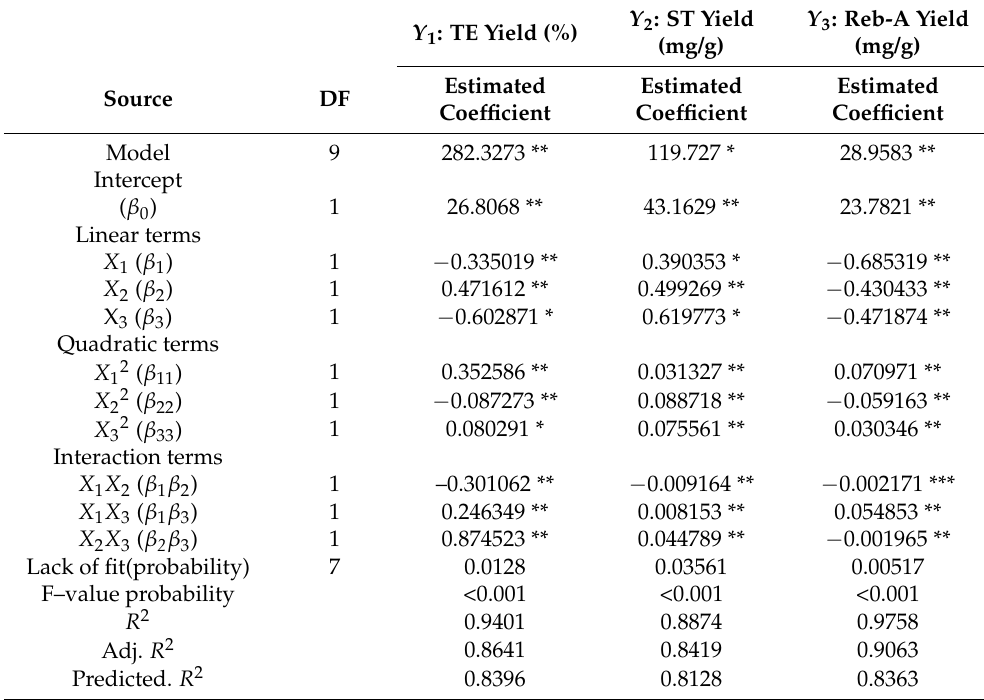
Table 3. ANOVA table showing the model terms (linear, quadratic, and interaction effects) of each variable and coefficients for model